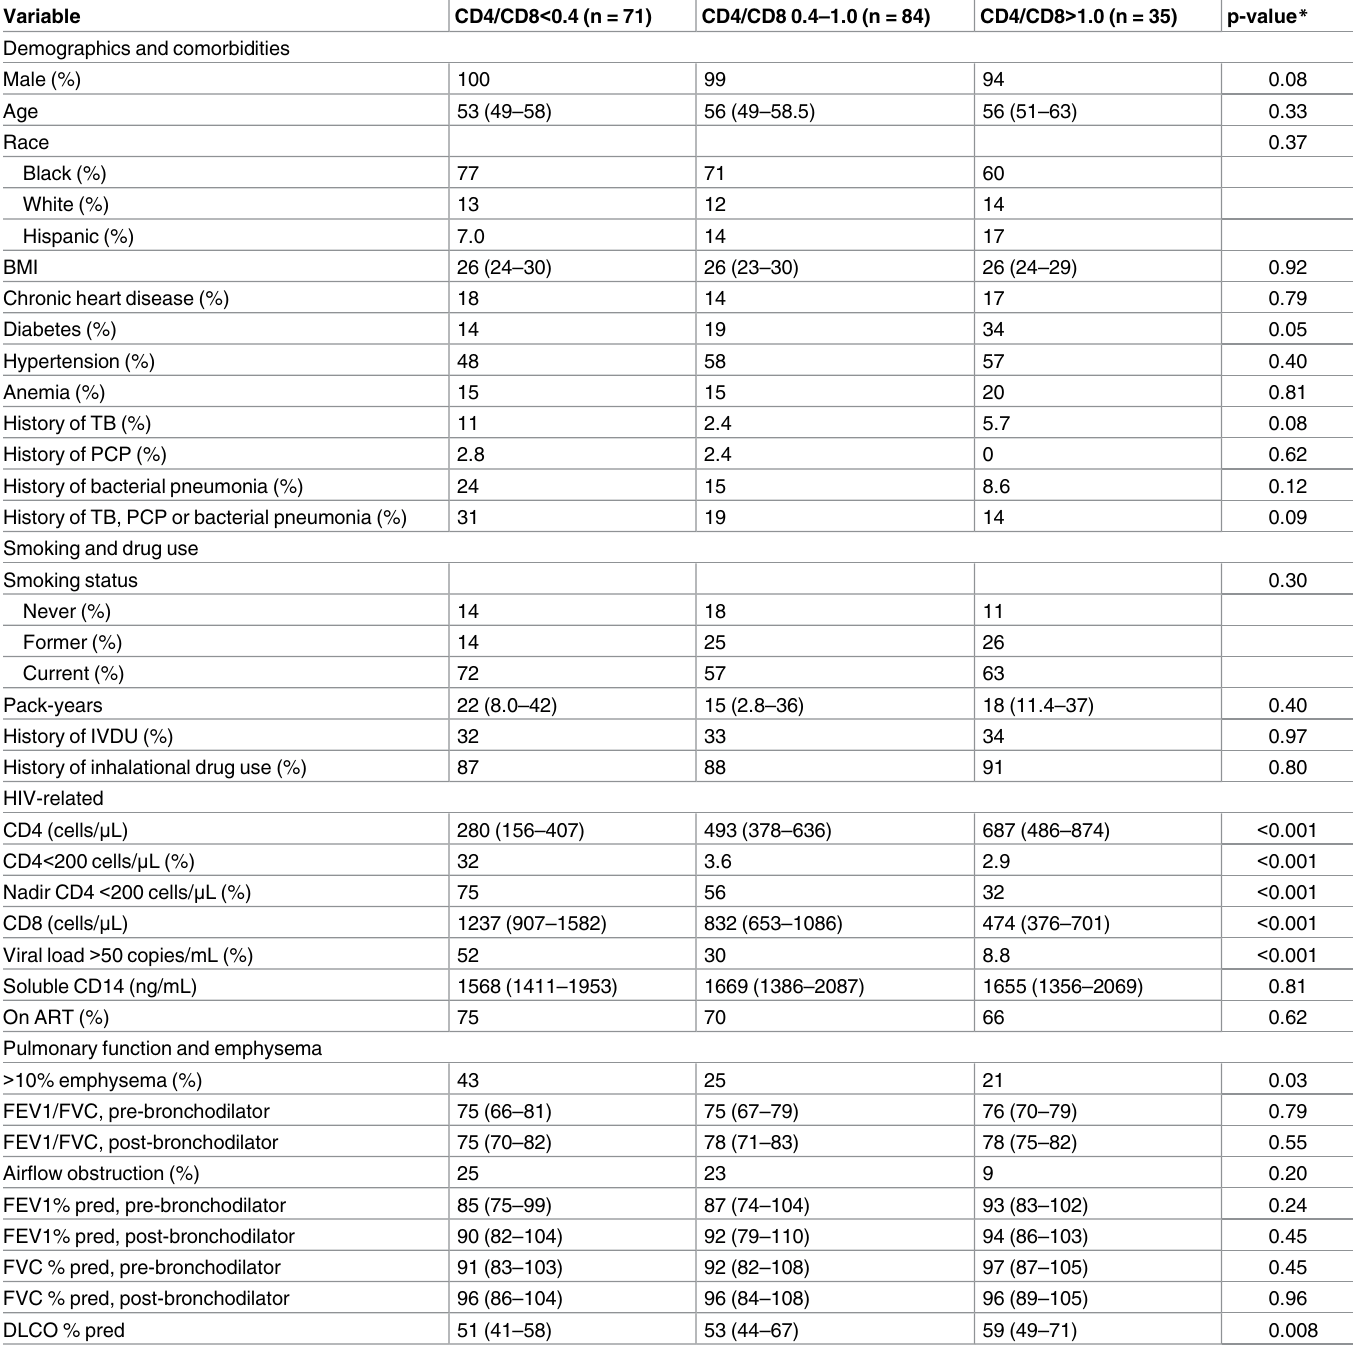
Table 1. HIV+ subject characteristics by CD4/CD8 ratio groups (n =